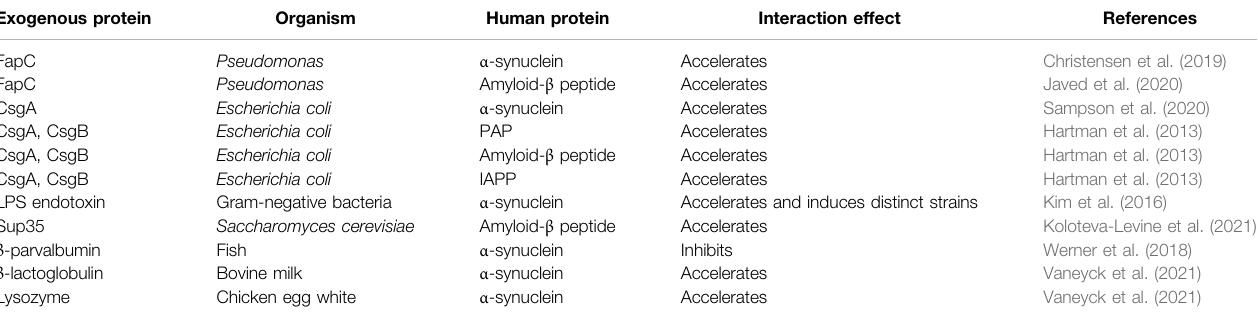
TABLE1| Examplesofinterspeciesinteractionsbetweenamyloidproteins.Listofexogenousamyloidproteins,thatcanbeinthegut,andthatinterferewiththeaggregation of unrelated human amyloid proteins. Exogenous